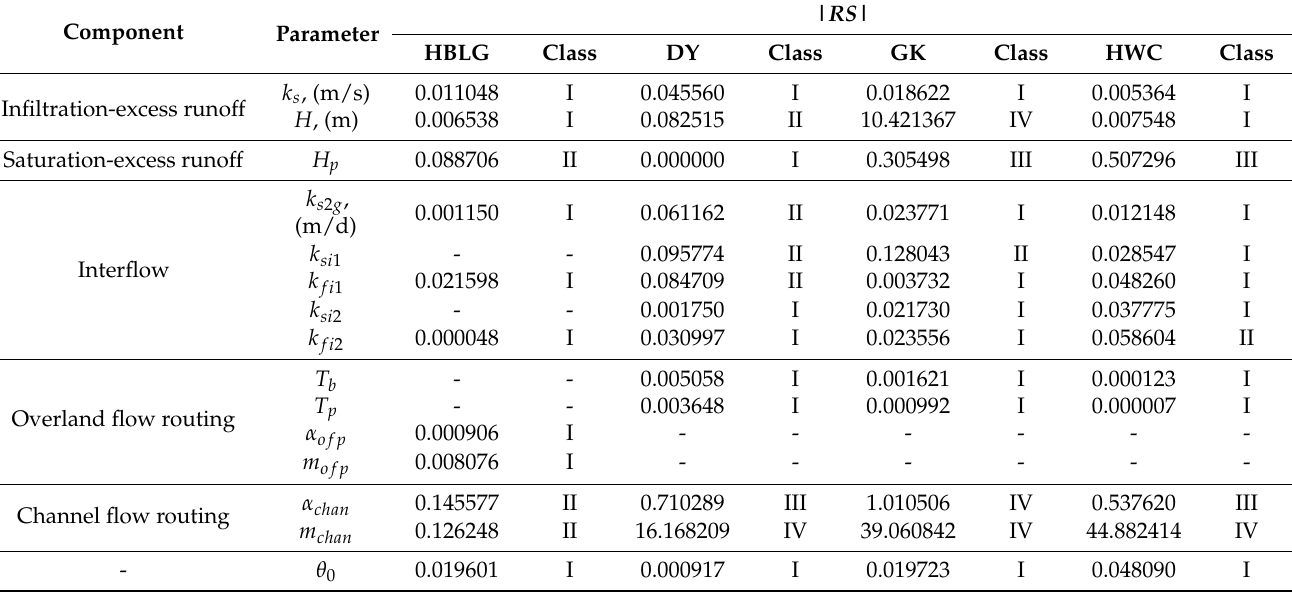
Table 7. Results of sensitivity